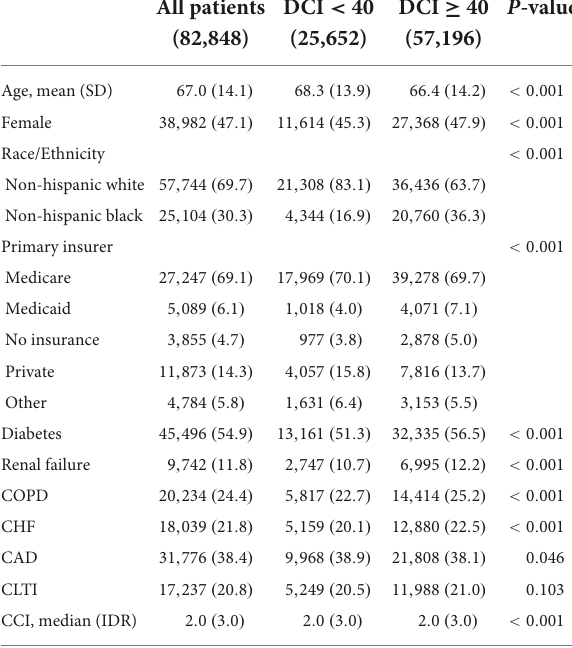
TABLE 1 Demographics and clinical characteristics by distressed communities index (DCI)